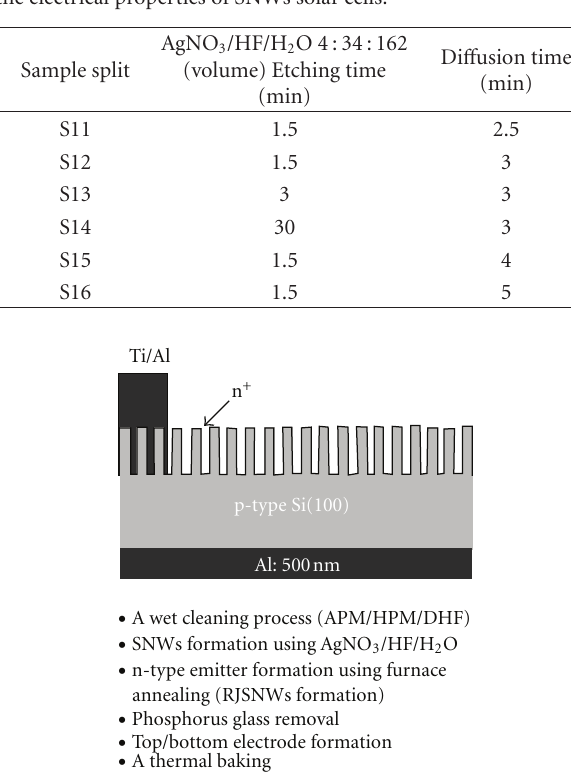
Table 2: Various etching times of AgNO 3 /HF/H 2 O mixture chem- ical solutions, as well as di ff usion times, were employed to explore the electrical properties of SNWs solar cells.